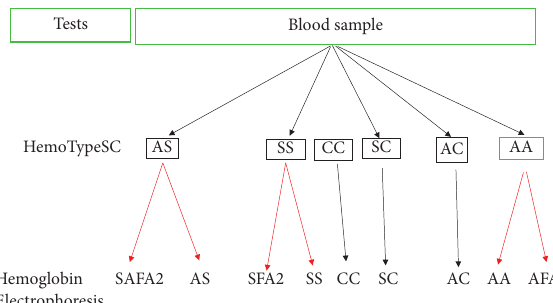
Figure 2: Decision-making algorithm for the diagnosis of sickle cell